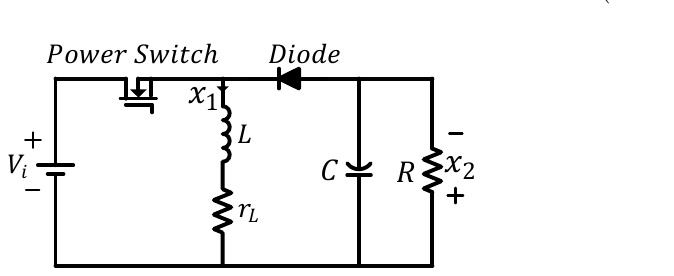
Figure 1. Buck/boost DC-DC converter and inducer current waveform in discontinuous conduction mode. The value of ∆ is zero in continuous operating mode.